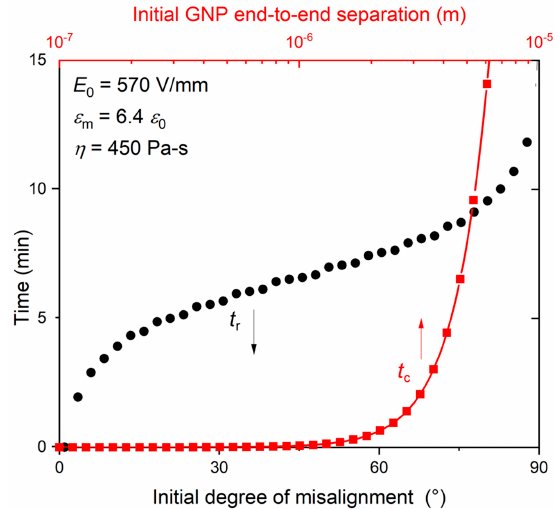
Figure 6. Rotational time (in black, t r ) required for individual GNP to become aligned with electric field as a function of initial degree of misalignment (bottom x -axis), and translational connection time (in red, t c ) for two aligned GNP to form end-to-end connection as a function of initial distance of separation (top x -axis). The melt viscosity and dielectric constant of the polymer matrix corre- spond to our EVA/GNP composite at 160 °C under the experimental conditions.